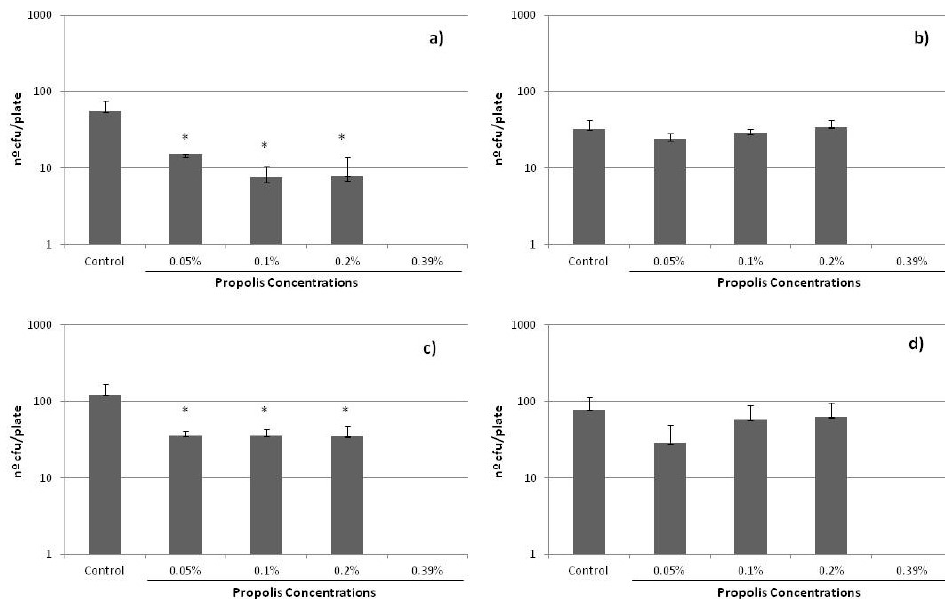
Figure 4. Effect of sub-MICs of SEEP on colonies forming on solid agar plates for the S. Figure 4. E ff ect of sub-MICs of SEEP on colonies forming on solid agar plates for the S. epidermidis epidermidis strains studied: ( a ) ATCC 12228, ( b ) HAM 892, ( c ) ATCC 35983, ( d ) ATCC strains studied: ( a ) ATCC 12228, ( b ) HAM 892, ( c ) ATCC 35983, ( d ) ATCC 35984. (*) indicates statistically 35984. (*) indicates statistically significant differences (i.e., p < 0.05) with respect to the significant di ff erences (i.e., p < 0.05) with respect to the control control samples.